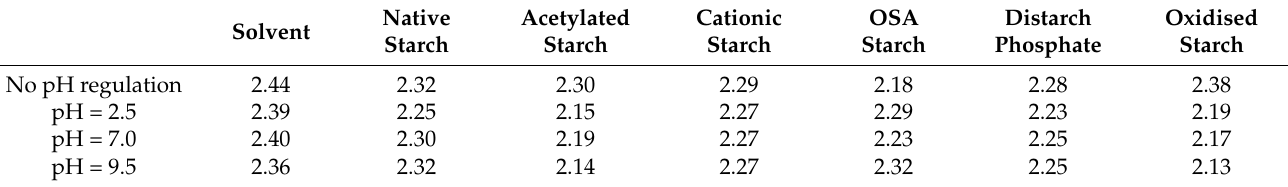
Table 2. Spin-lattice relaxation time T 1 values [s] for the analysed starch samples.